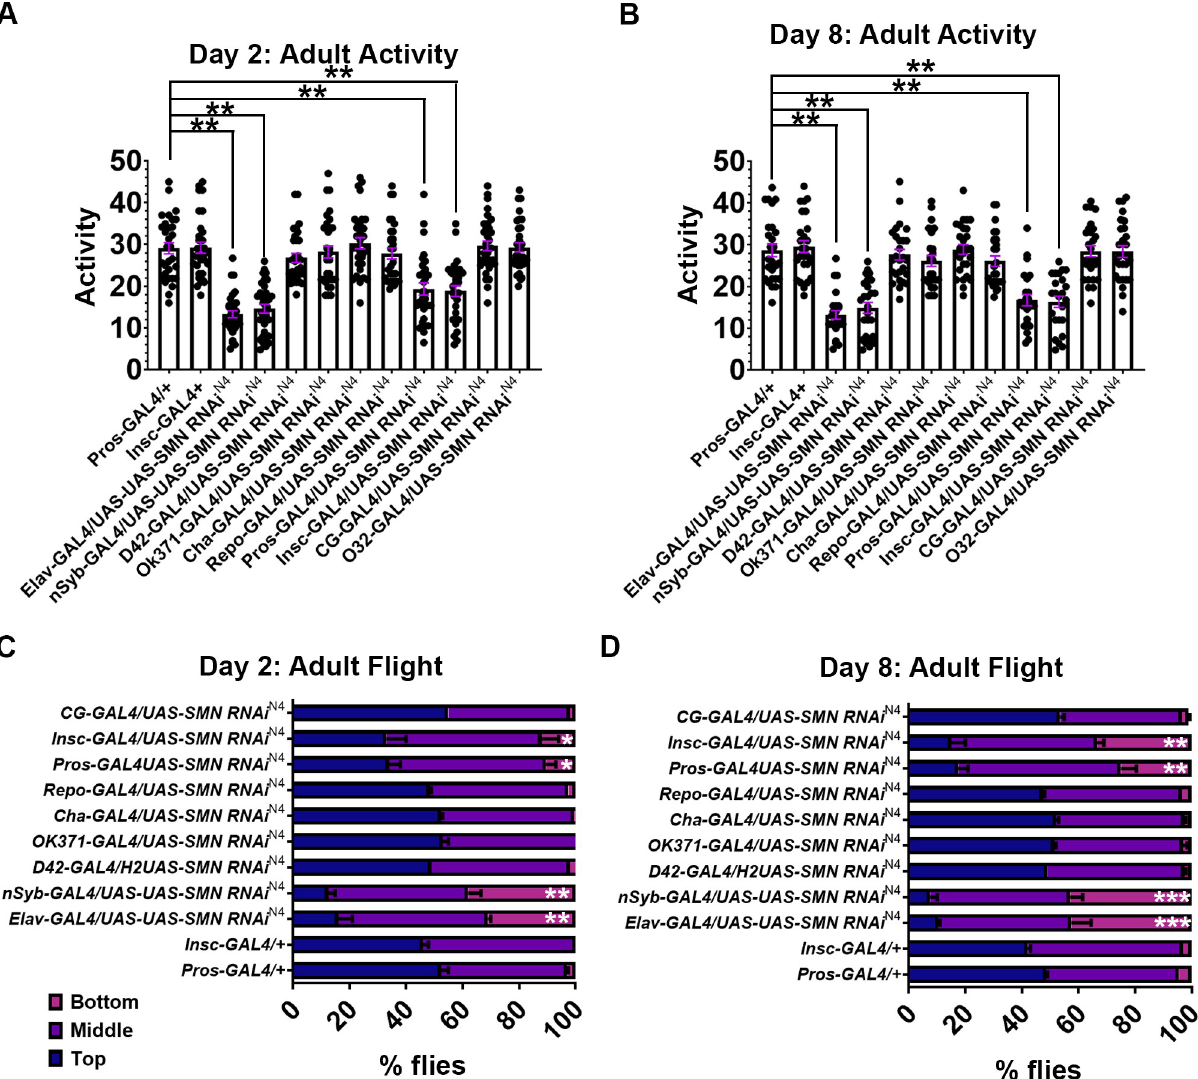
Fig 3. Survival motor neuron ( Smn ) knockdown in neurogenic cell types leads to adult motor dysfunction. Flies were tested for motor activity, (A) and (B), and flight ability (C) and (D) at 2 days (A) and (C), and 8 Days (B) and (D). Drosophila activity was detected in adult flies over 1 day using the Trikinetics activity monitors in controlled conditions; (A and B) only Pros-GAL4 / UAS-SMN-RNAi N4 and Insc-GAL4/UAS-SMN-RNAi N4 progressively declined in activity over 2 (F; �� P < 0.01, n = 20; Kruskal–Wallis test with Dunn’s multiple comparisons) and 8 days (G; ��� P < 0.001; n = 20; Kruskal– Wallis test with Dunn’s multiple comparisons); (C and D) Pros-GAL4 ; UAS-SMN-RNAi N4 and Insc-GAL4/UAS-SMN-RNAi N4 flies showed a significant reduction in flight ability, with more flies residing at the bottom of the chamber, over 2 (F; � P < 0.05; �� P < 0.01; n = 40; Kruskal–Wallis test with Dunn’s multiple comparisons) and 8 days (G; ��� P < 0.001; n = 40; Kruskal–Wallis test with Dunn’s multiple comparisons). All error bars [SEM].